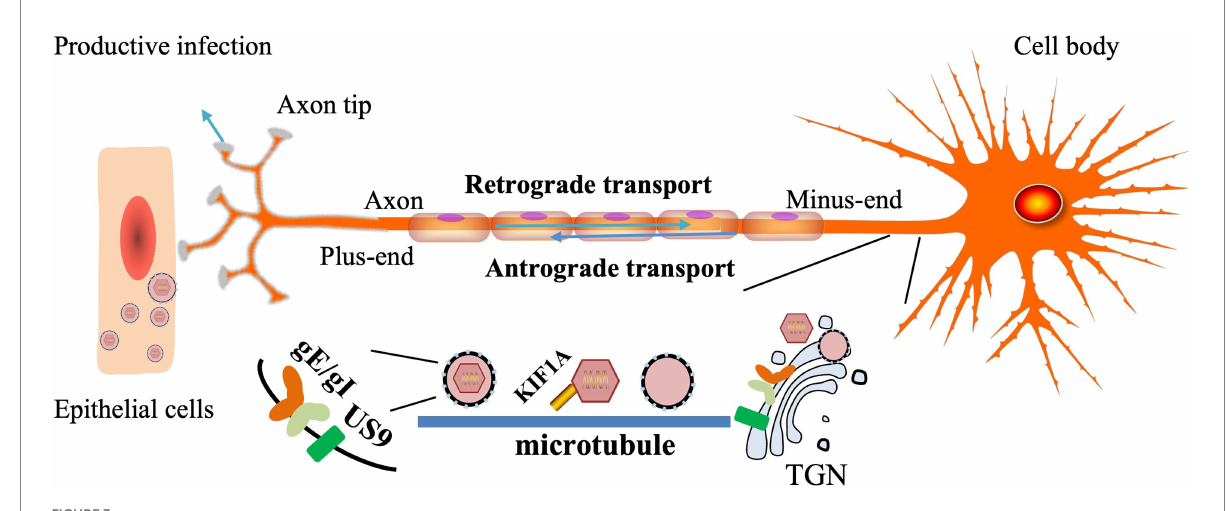
FIGURE 3 Models for how HSV gE/gl and US9 promote axonal transport (Howard et al., 2013, 2014). The TGN membrane vesicles containing gE/gI and US9 present in neuronal-cell bodies are adjacent to microtubules and serve as platforms for the assembly or loading of tegument-coated capsids onto microtubule